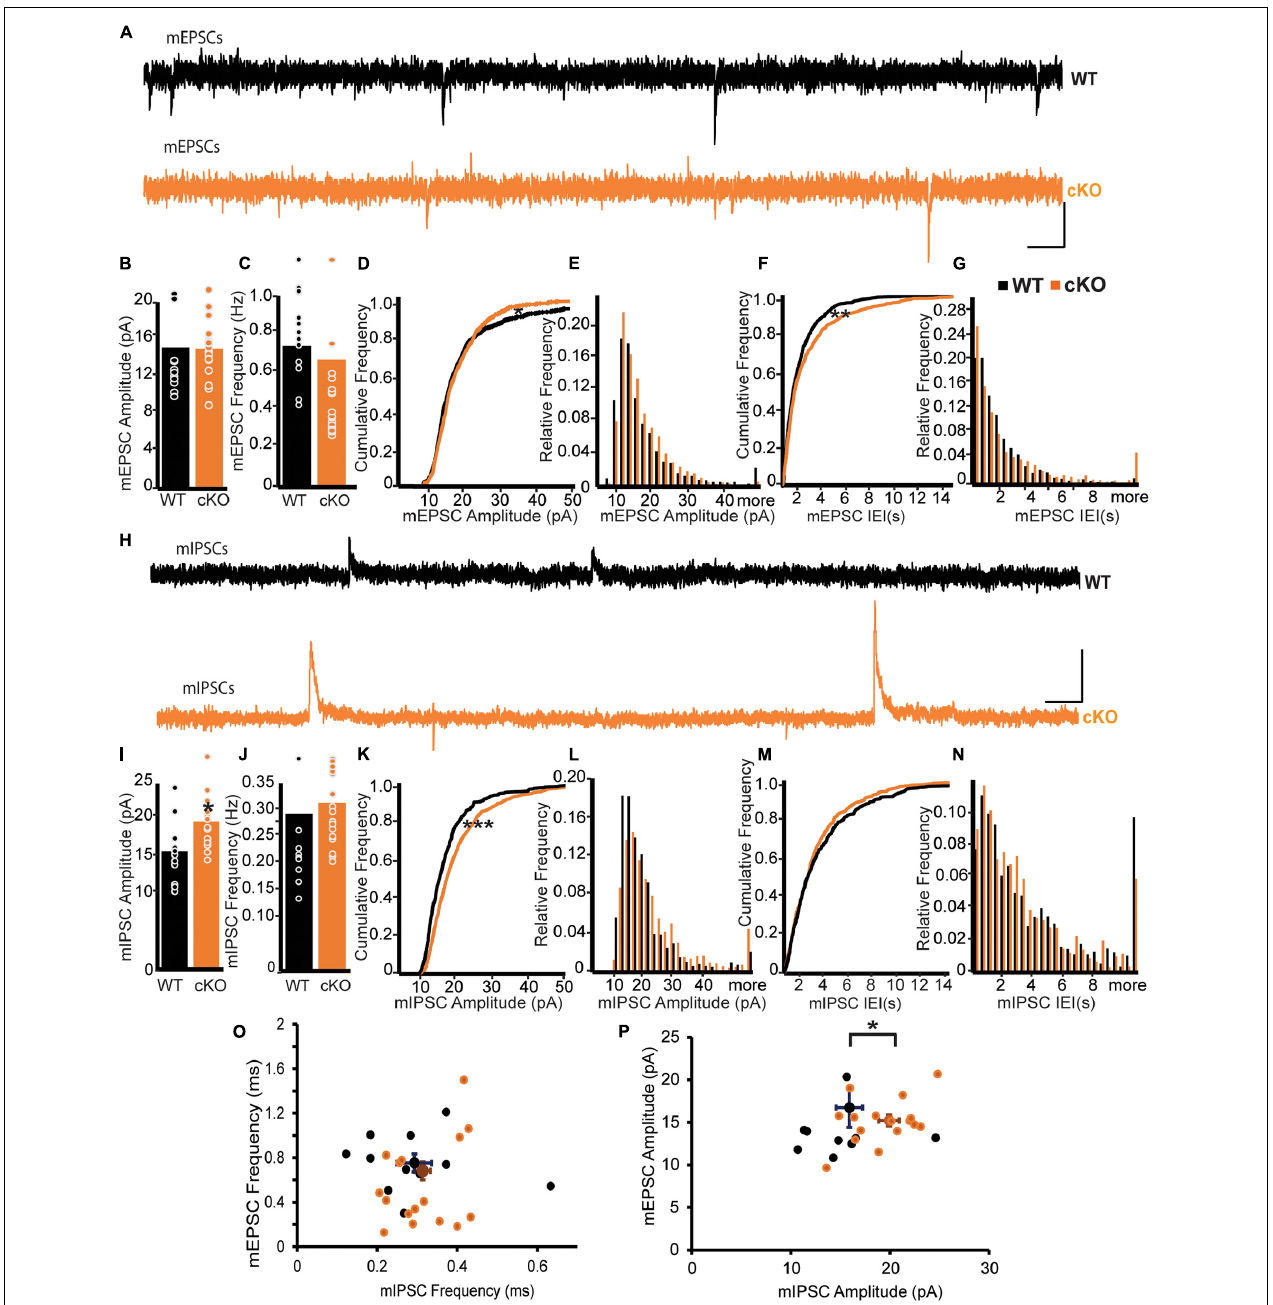
FIGURE 1 | ErbB4 deletion from mpITCs results in enhanced mIPSC amplitude. (A–G) Properties of mEPSCs in WT ( n = 13) and cKO mice ( n = 18). (A) Sample traces of mEPSPs in WT (top, black) and cKO mice (bottom, orange). Scale bars: 10 pA, 0.2 s. (B) Bar graphs of mean mEPSC amplitudes and mEPSC frequencies. Panel (C) showing no difference between WT and cKO mice. p = 0.3088 and 0.7145 for amplitudes and frequencies, respectively. (D) Cumulative probability distributions of mEPSC amplitudes in WT and cKO. p = 0.0221. (E) Cumulative histogram summarizing the distribution of mEPSC amplitudes in WT and cKO. (F) Cumulative probability of mEPSC inter-event intervals (IEIs) in WT and cKO. p = 0.0052. (G) Cumulative histogram summarizing the distribution of mEPSC IEIs in WT and cKO. (H–N) Properties of mIPSCs in WT ( n = 11) and cKO mice ( n = 17). (H) Sample traces of IPSPs in WT (top, black) and cKO mice (bottom, brown). Scale bars: 10 pA, 0.1 s. (I) Enhanced mIPSC amplitudes in mpITCs recorded from cKO mice. p = 0.0200. (J) No difference in mean mIPSC frequencies between WT and cKO mice. p = 0.6202. (K) Cumulative probability of mIPSC amplitudes in WT and cKO. p < 0.0001. (L) Cumulative histogram summarizing the distribution of mIPSC amplitudes in WT and cKO. (M) Cumulative probability of mIPSC IEIs in WT and cKO. p = 0.2779. (N) Cumulative histogram summarizing the distribution of mIPSC IEIs in WT and cKO. (O,P) Analysis of mEPSCs and mIPSCs recorded at –70 mV (Cl − reversal) and 0 mV, respectively, in the same cells. WT ( n = 11), cKO mice ( n = 17). mEPSC frequency/mIPSC frequency (O) were similar in WT and cKO mice. p = 0.2180; but mEPSC amplitude/mIPSC amplitude (P) were reduced in cKO mice. p = 0.011. Cumulative probability and mean data in WT and cKO mice were compared using KS-test and Student’s t -test, respectively. * p < 0.05; *** p <